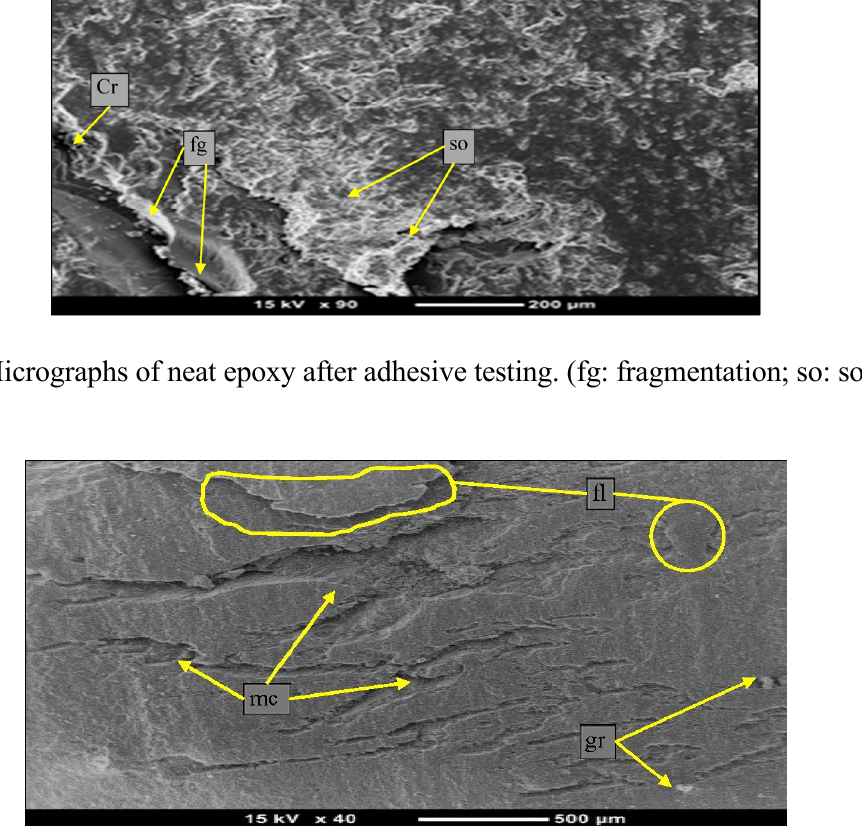
Figure 9. Micrographs of 5% graphite/epoxy composites after adhesive testing. (fl: film transfer; gr: graphite; mc: